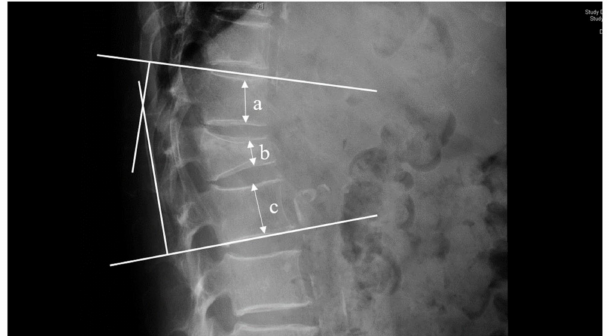
Figure 3. Measurement of vertebral collapse and kyphosis. Vertebral collapse (%) was measured as follows: [(a + c)/2 − b]/ [(a + c)/2] × 100. The kyphosis Cobb was measured by using the Cobb method. a = upper vertebral height, b = affected vertebral height, c = lower vertebral